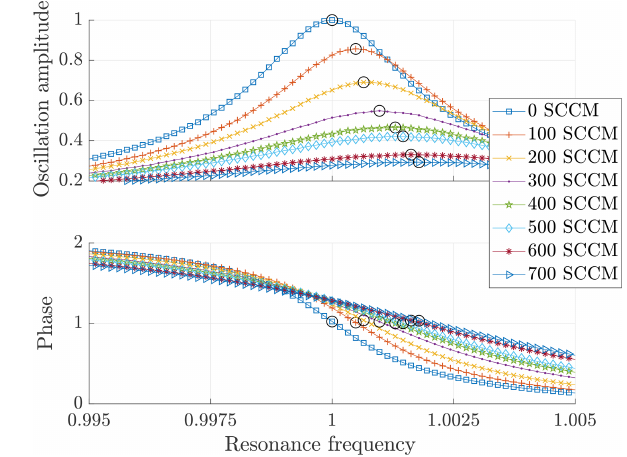
Figure 2. Oscillation amplitude and phase as a function of the res- onance frequency at different volume flows (the circles mark the oscillation maxima and the associated